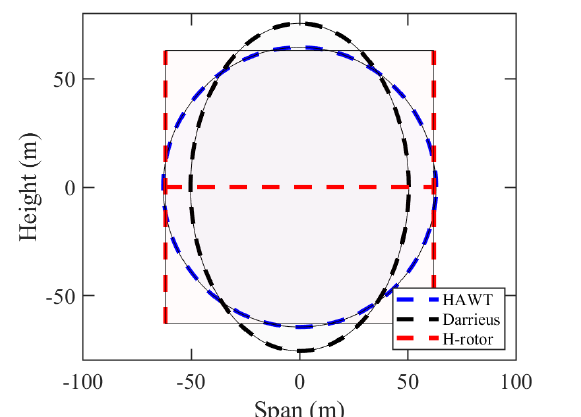
Figure 3. Swept areas ( A ) of HAWT (blue dotted line), Darrieus (black dotted line) and H − rotor (red dotted line). The rated velocities ( U r ) are 11.4, 11.3 and 11.2 m/s, whilst P is 5, 4 and 5 MW, respectively. For these computations, we utilised C P,max = 0.48 for the HAWT, and C P,max = 0.40 for the